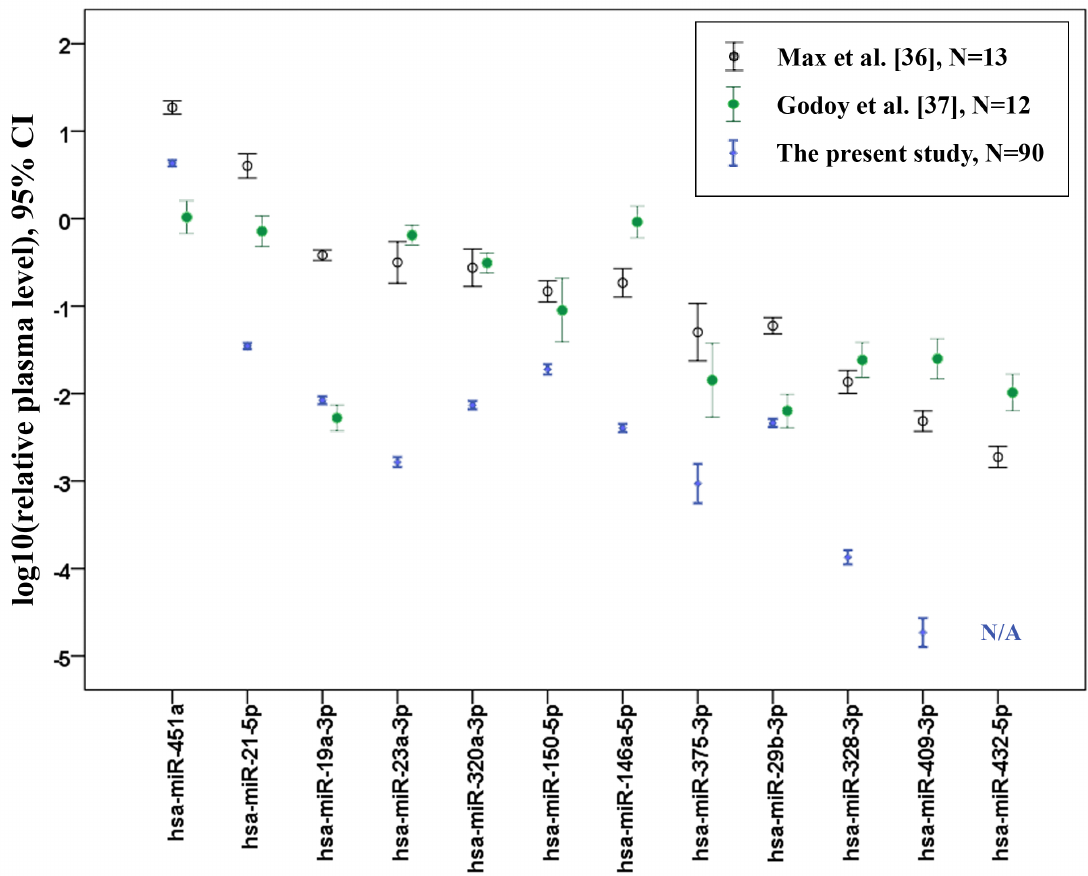
Figure 5. Comparison of miR-16-5p-normalized relative plasma levels between the present study and the two most recent miRNA plasma sequencing studies performed on healthy adults. Error bars represent the mean and 95% confidence interval (CI). N/A: not applicable.